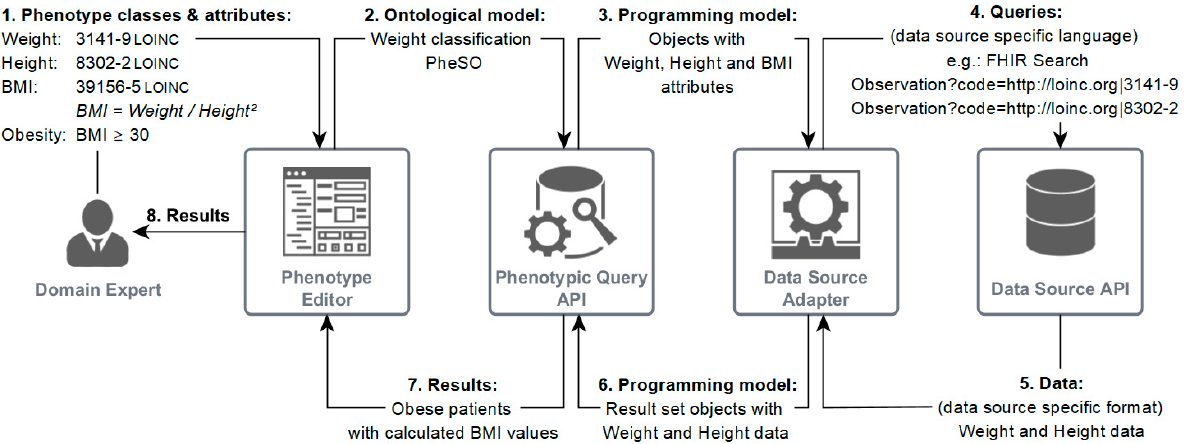
Figure 4. Possible architecture to implement the transformation of ontology-based phenotypic models to query languages and to obtain the resulting data sets. The data source adapter can be replaced by any kind of query-specific adapter (e.g., FHIR Search adapter).